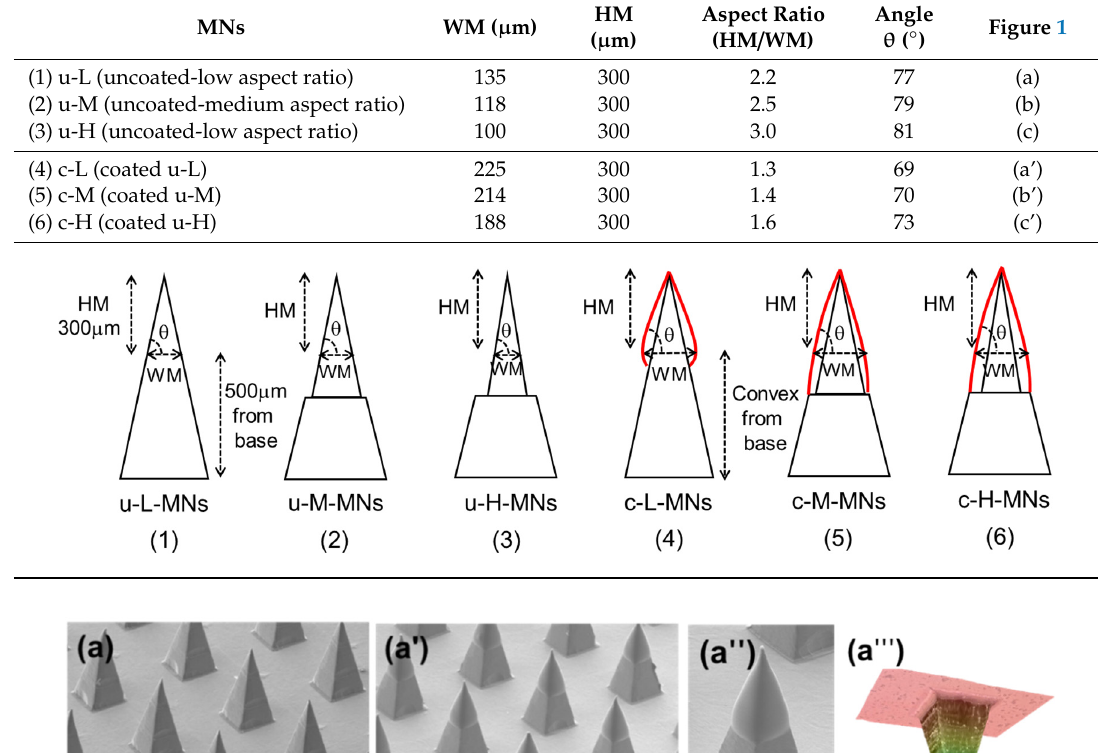
Table 2. Information on the geometries of three aspect ratio of microneedles (MNs) before and after coating. HM—height; WM—width.